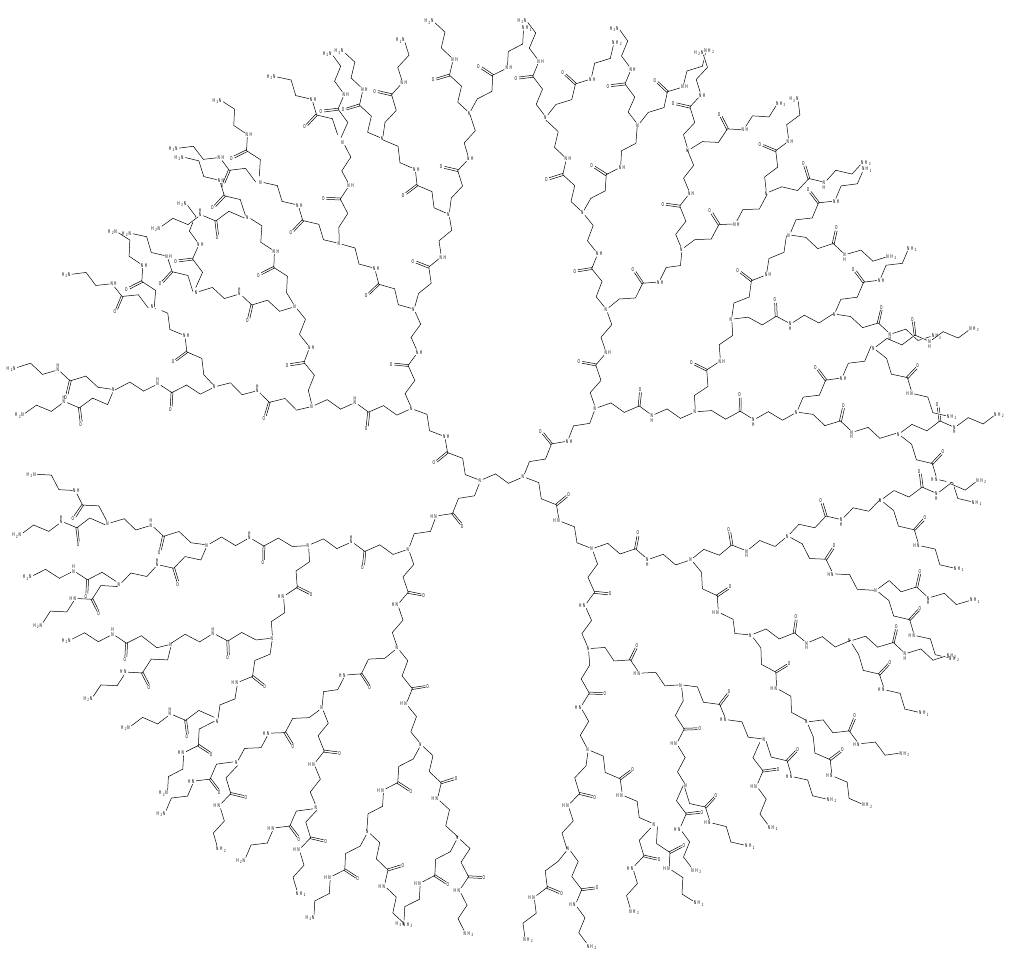
Figure 1. Structure of PAMAM dendrimer, Generation